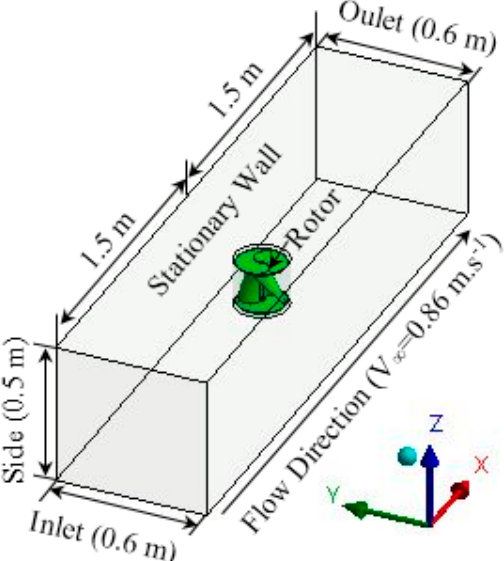
Figure 5. Schematic representation of the computational domain.